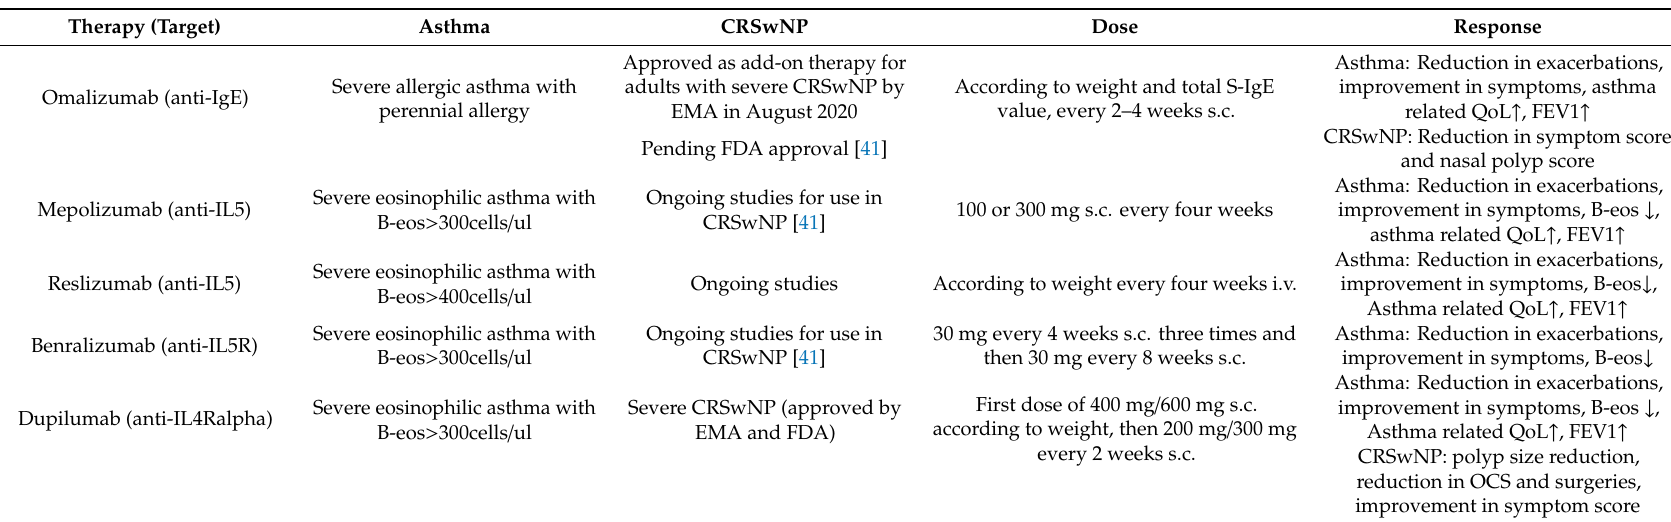
Table 1. Monoclonal antibodies in the treatment of di ff erent airway